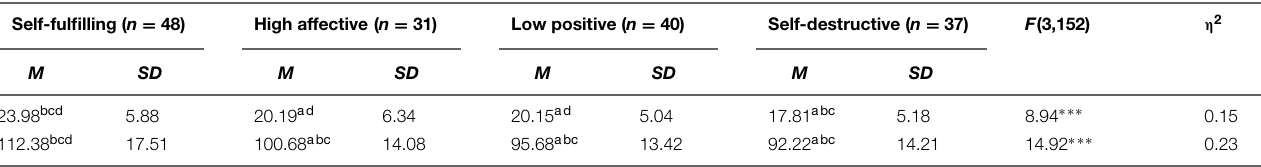
TABLE 1 | Means differences in life satisfaction and well-being in affective profiles.